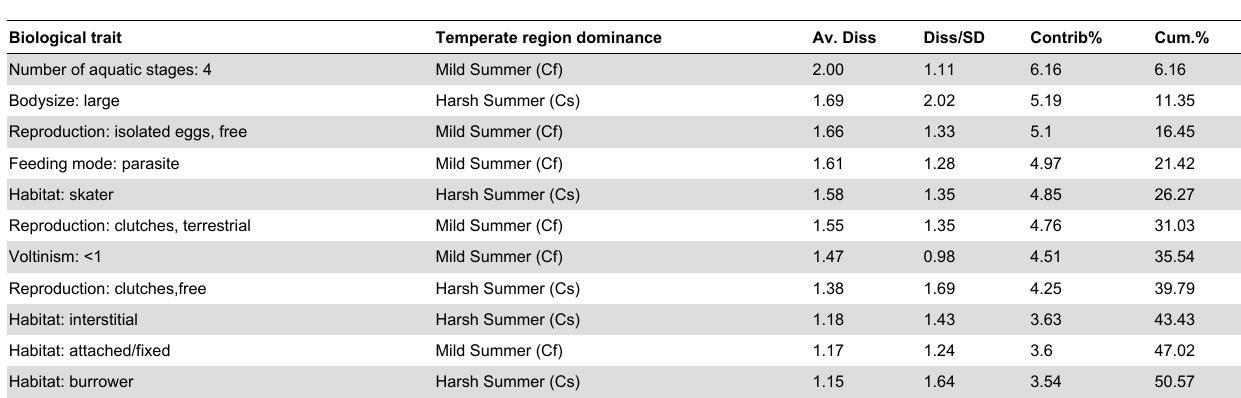
Table 3. Results of the SIMPER analysis.